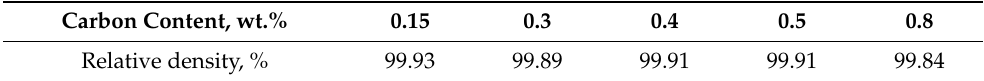
Table 4. Resulting relative densities depending on the carbon content. Carbon Content,